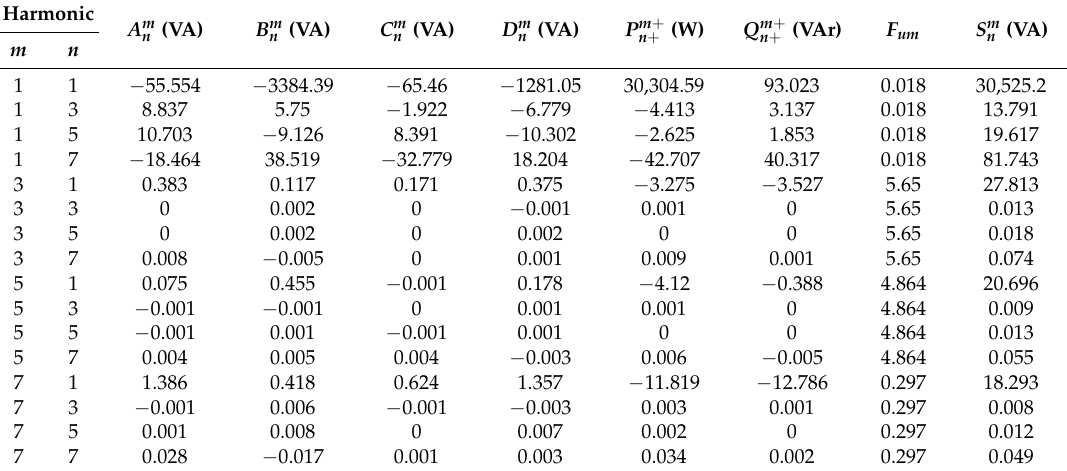
Table 7. Results in load 1.